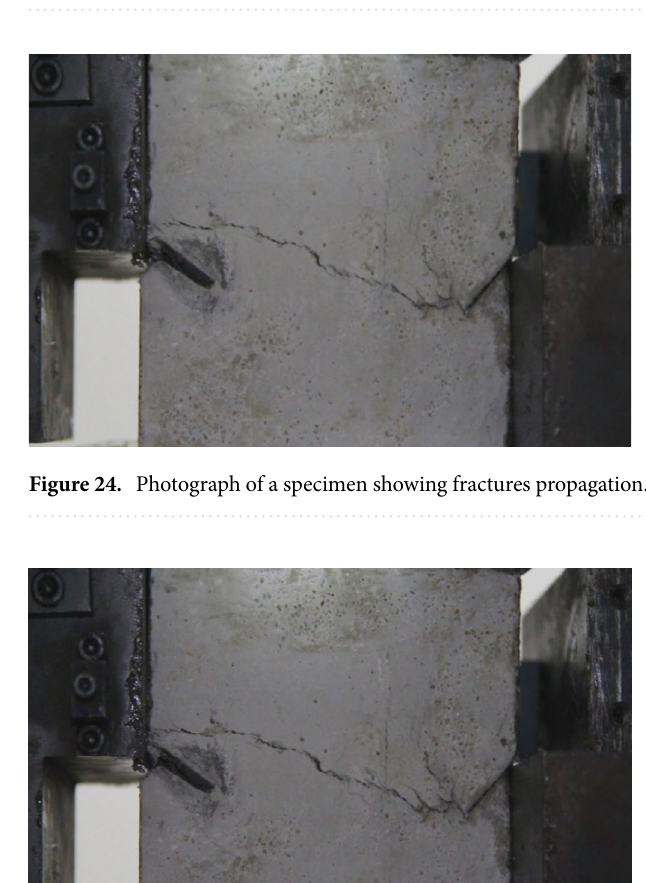
Figure 23. Photograph of a specimen showing fractures appearing in the middle of the rock mass.